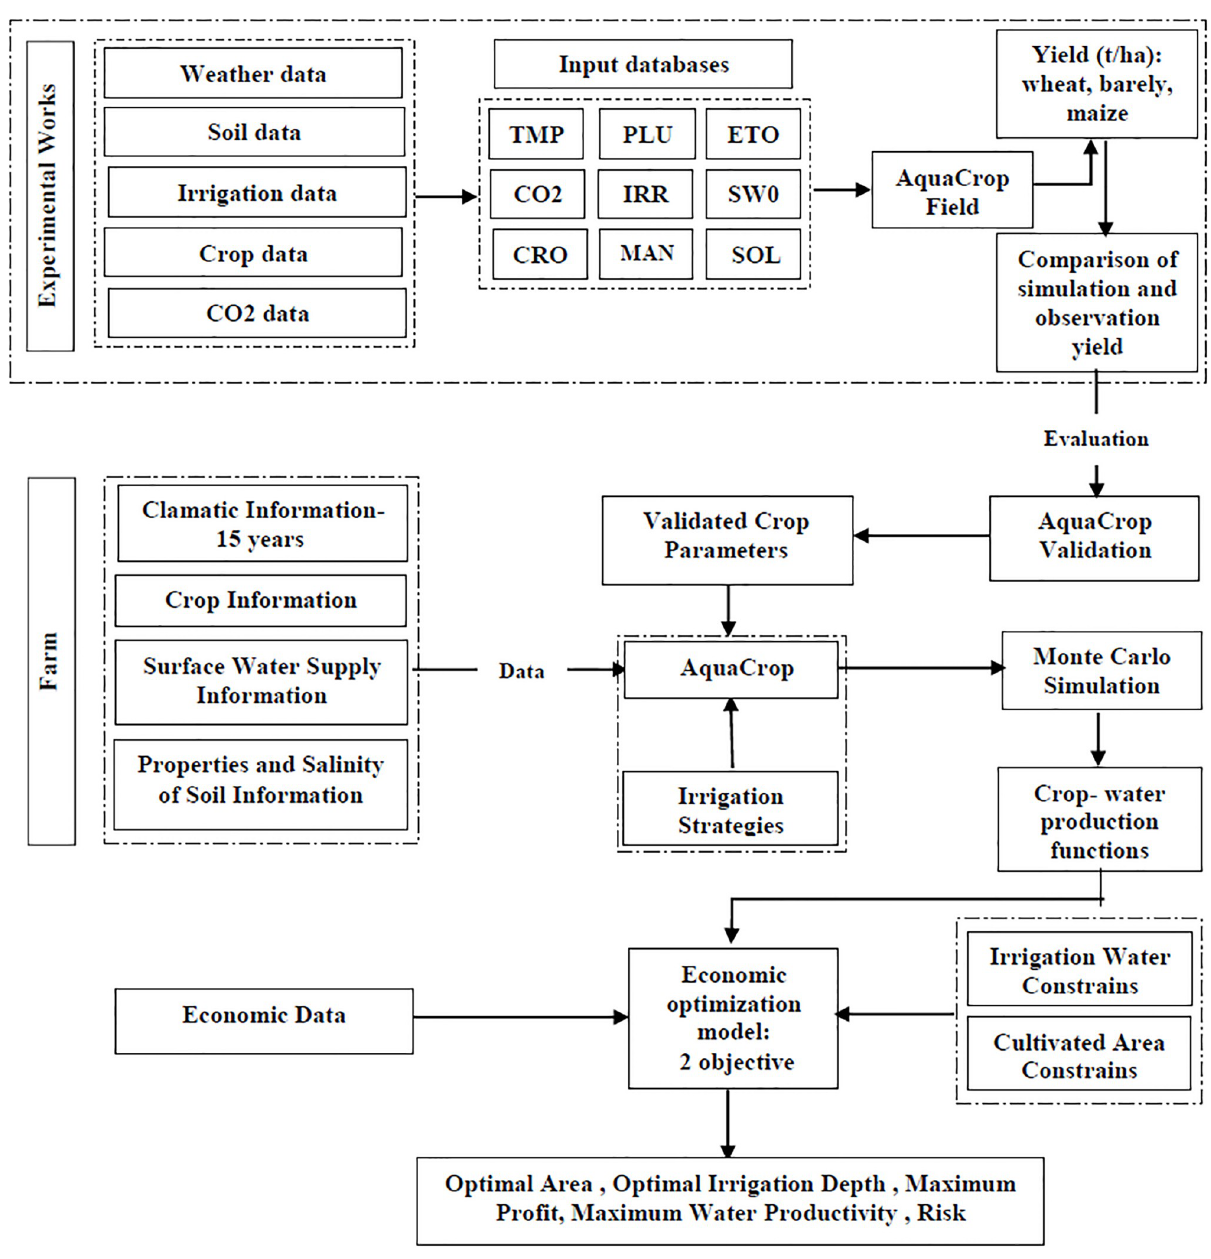
Fig 1. Flowchart of optimizing the water and land allocation in the